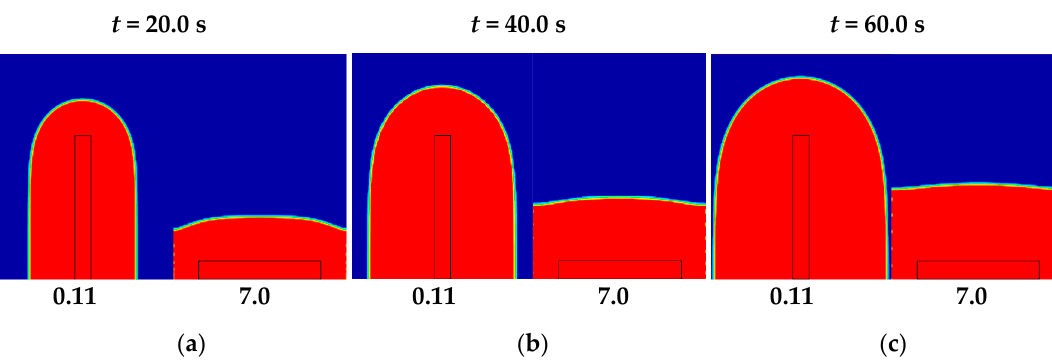
di ff erent instants of time: t = 20.0 s (Figure 8a), 40.0 s (Figure 8b), and 60.0 s (Figure